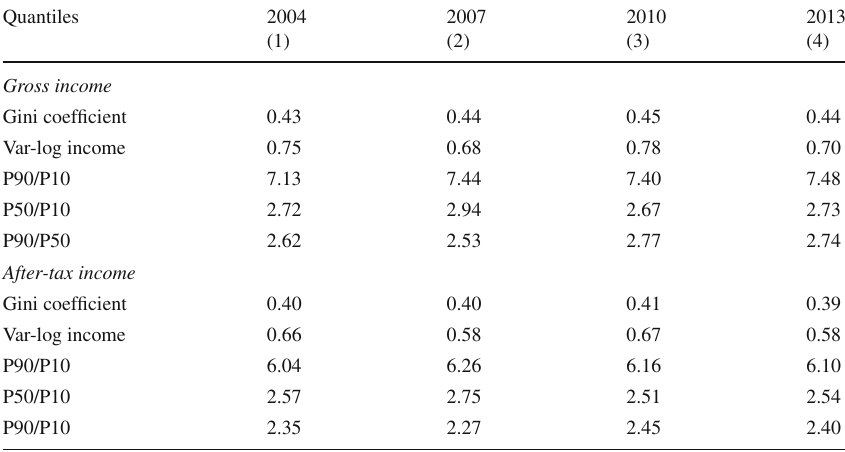
Table 17 Evolution of gross and after-tax inequality indices in EFF (fiscal households)